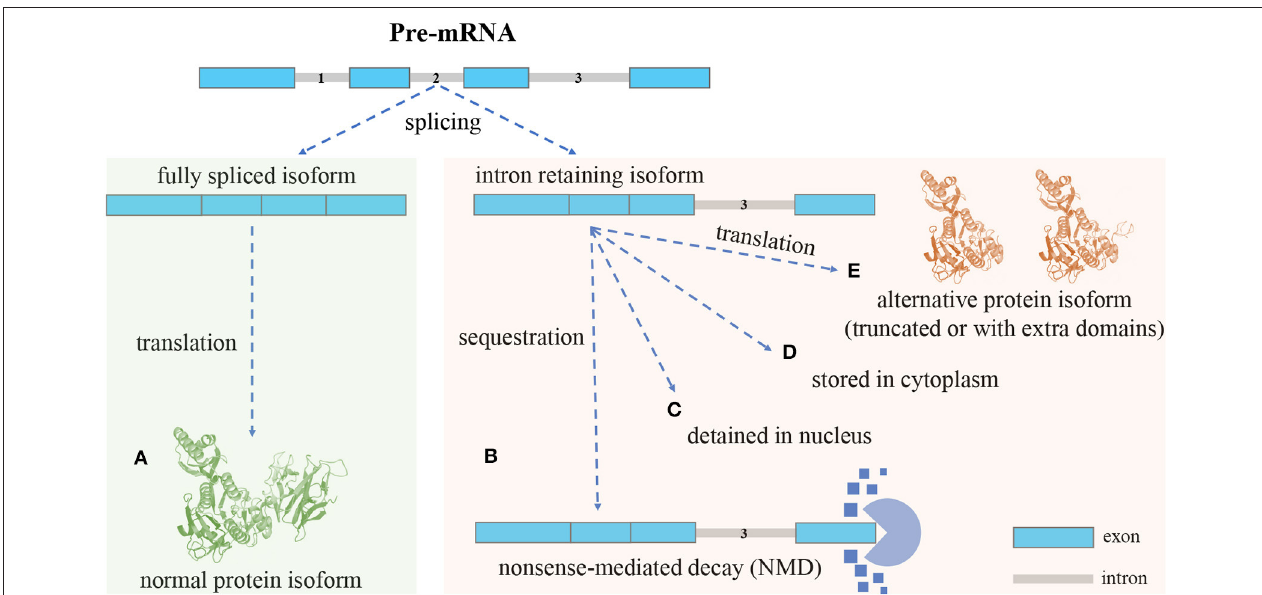
FIGURE 1 | An overview of the intron retention (IR) mechanism: different isoforms can be produced from a single gene through AS. (A) , Isoforms with introns fully spliced are sent out of the nucleus for translation. Intron-retaining isoforms (IRIs) can be generated through IR (no intron retention): (B) , In most cases, the IRIs are degraded by the nonsense-mediated decay (NMD) pathway, the reason being that retained introns often contain premature termination codons (PTCs) that can trigger NMD (with intron retention): (C) , In some cases, the IRIs are detained in the nucleus, and in response to stimuli these IRIs can undergo further splicing to remove the retained intron, before being exported out of nucleus for translation (with intron retention): (D) , In the case of cytoplasmic splicing, IRIs are shuttled to the cytoplasm for preservation and may be subject to further splicing (with intron retention): (E) , In yet another case, IRIs escape from the NMD pathway and are translated into protein isoforms, which, compared with normal protein isoforms, are often truncated and may lose domains; however, it could also be that the alternative protein isoforms include extra domains formed by the amino acid sequences translated from retained introns (with intron